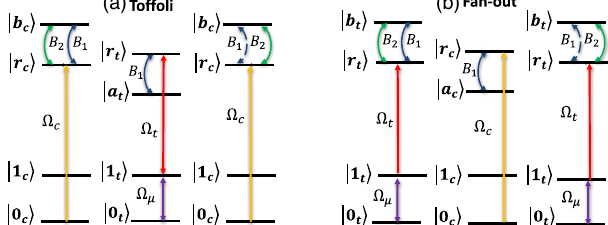
FIG. 1. Level scheme for three-qubit (a) Toffoli and (b) fan-out gates. States j 0 c;t i , j 1 c;t i are long-lived qubit basis states, and j r c;t i , j a c;t i , and j b c;t i are Rydberg states of the control and target atoms. Hadamard qubit gates ( π = 2 pulses) on the target atoms are implemented by the Ω μ classical field. Control states j 0 c i and target states j 1 t i are coupled to the Rydberg levels j r c;t i by Ω c;t lasers. The resonant exchange interaction between control and target Rydberg atoms j r c r t i ↔ j a c;t b c;t i with strength B 1 ≫ Ω t drives the dark-state dynamics, while an intracomponent ex- change interaction B 2 perturbs the gate